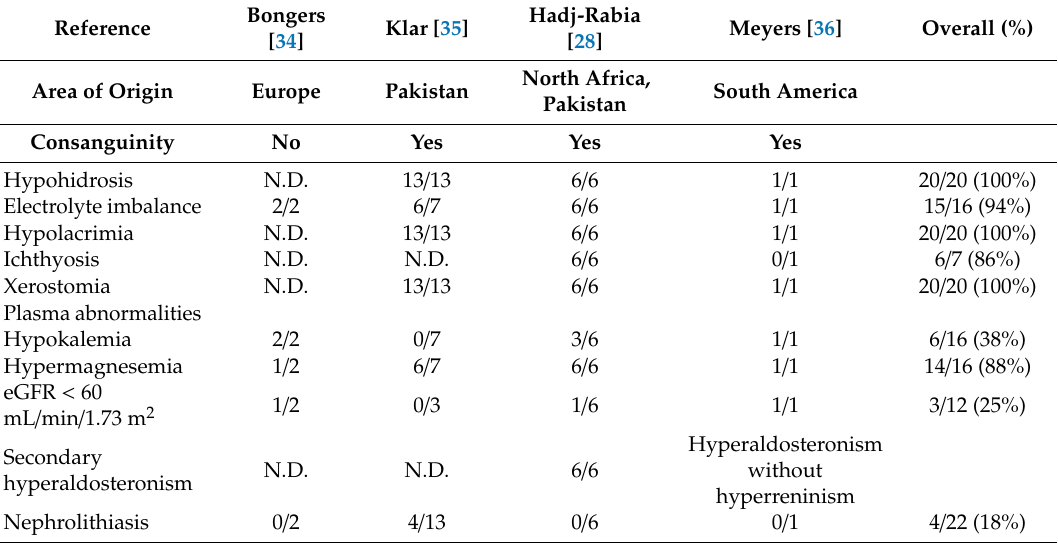
Table 1. Similarities and di ff erences among phenotype in patients with HELIX